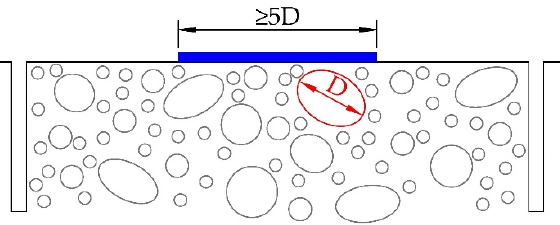
Figure 9. Length of measuring grid of strain gauges considering aggregate grain size.